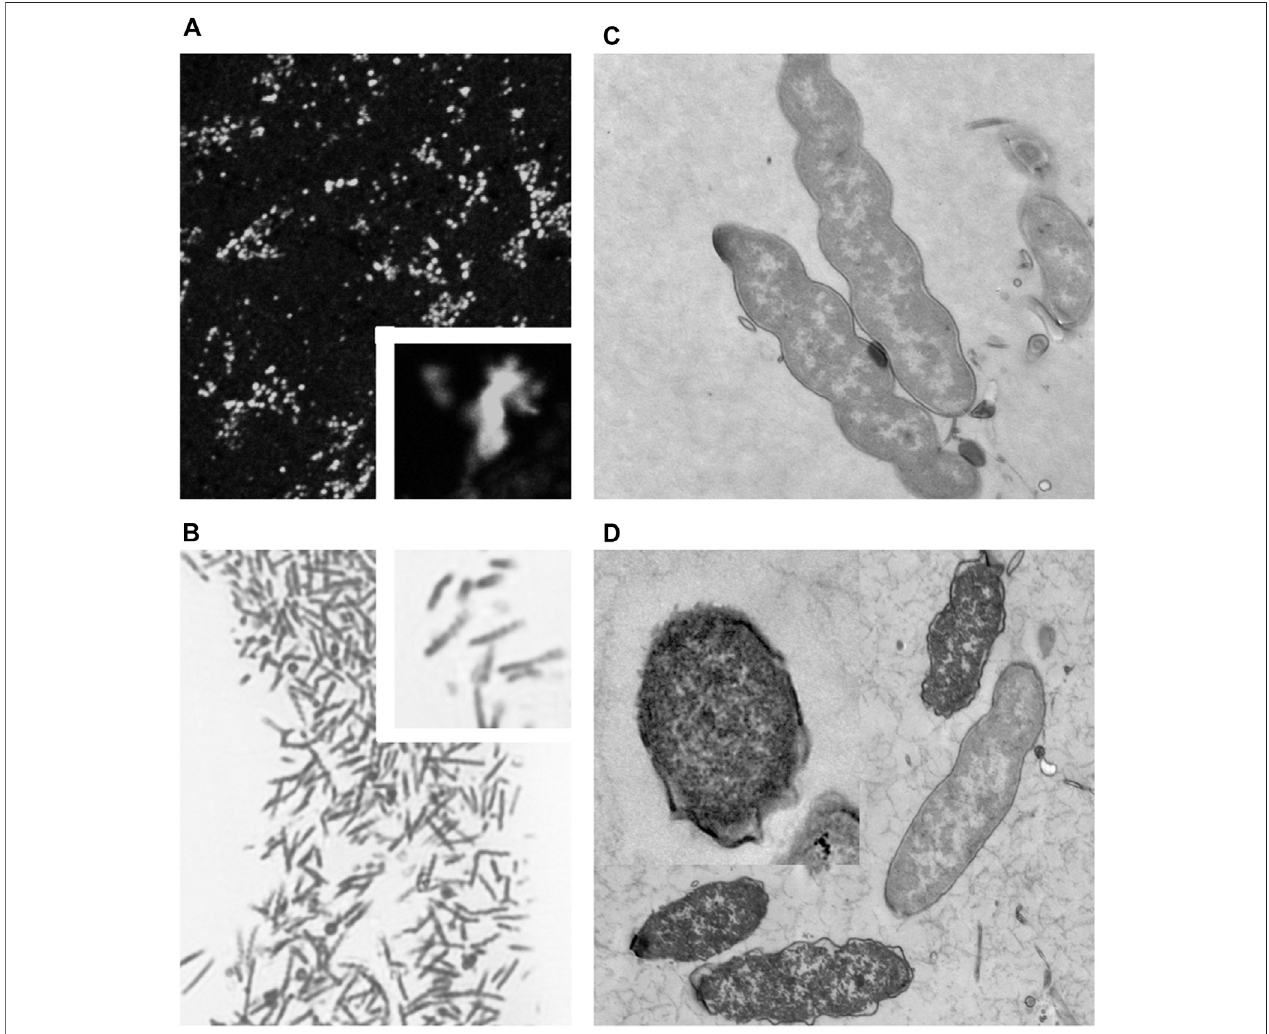
FIGURE 11 | Fluorescent, light, and electron microscopic observations of the cultured NHPH (A) By fl uorescent immunohistochemical observation of the cultured NHPH using the HsvA antibody, many bacteria were observed in the incubation medium, X 400. Inset X 1800. (B) By light microscopic observation of the toluidine-blue stainedEpon-embedded2-µMsection,manyspiralbacilliwereobserved,X600.InsetX1800. (C) ElectronmicroscopicobservationoftheculturedintactNHPHinpH3. Intact bacilli were observed with fl agella, X 15, 000. Ruthenium red en bloc staining. (D) Electron microscopic observation of the cultured NHPH in pH 6.5. Ruthenium red en bloc staining. The cytoplasm of some of the bacilli became condensed and homogeneous, and its plasma membrane became irregular, coinciding with the observation reported in the coccoid form, X 12,000, Inset x15, 000.